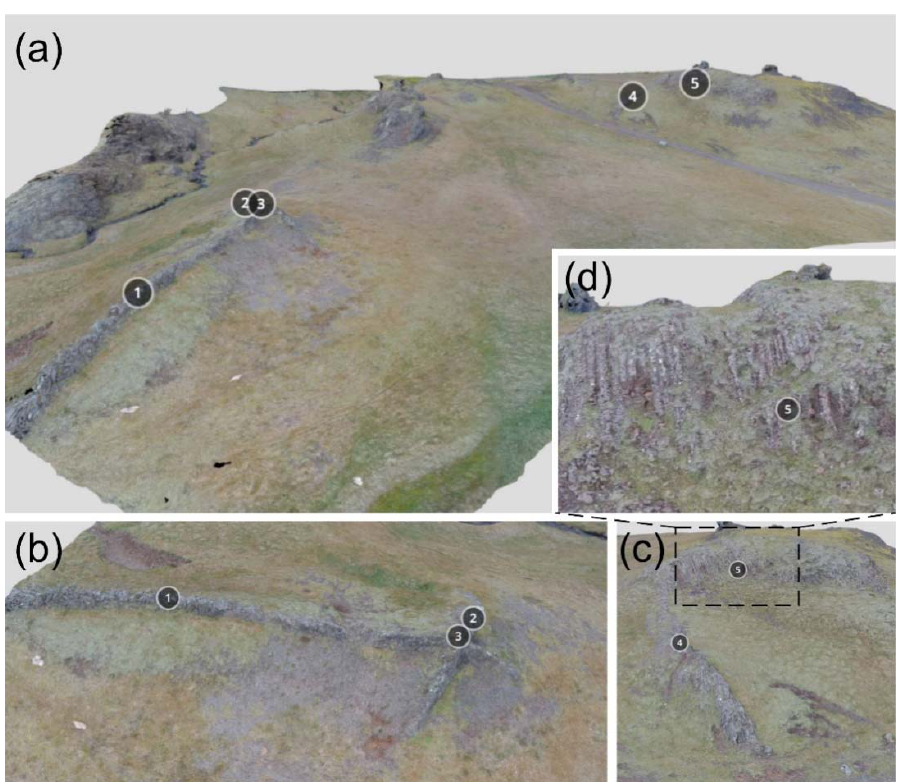
Figure 12. ( a ) Overall view of the 3D model. Numbers are interactive annotations that can be clicked online, providing the viewer with explanations about particularly relevant features; ( b ) detail of the cross ‐ cutting relationship (annotation 2) between a dyke and an inclined sheet; ( c ) a dyke (annotation 4) abruptly turning into a succession of sills, stacked atop each other; ( d ) focus on the sills (annotation 5), featuring an outstanding columnar